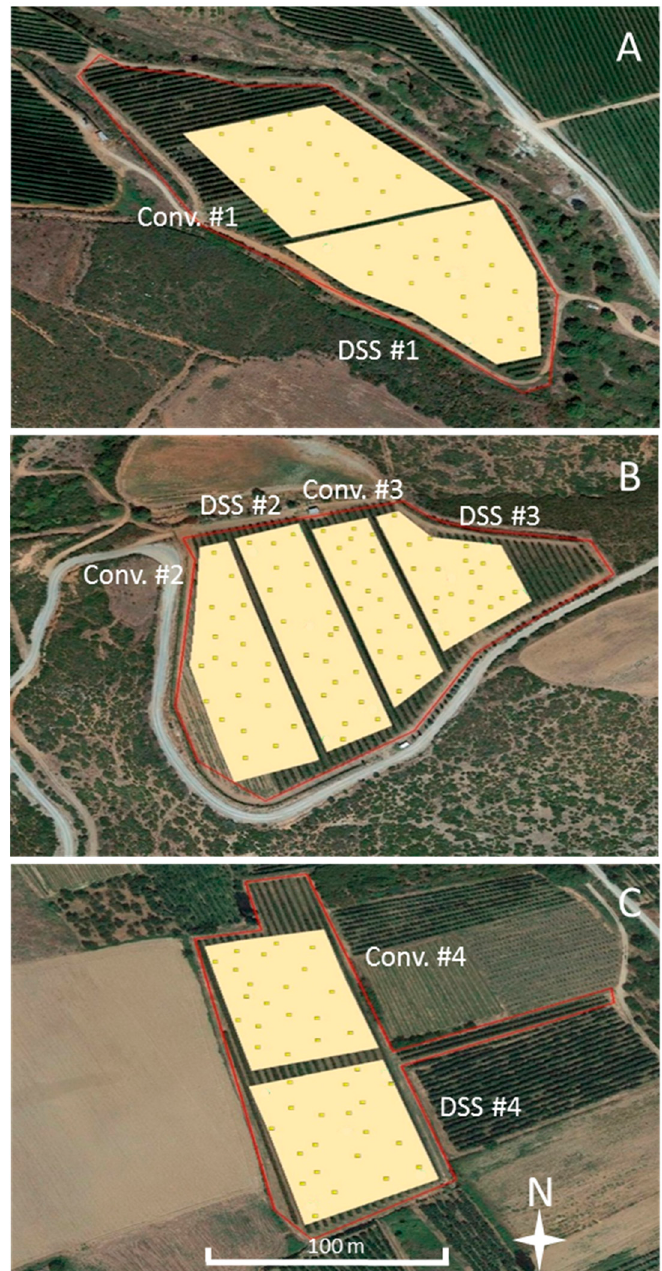
Figure 5. Digitization of coventionally treated (Conv.) and DSS treated plots in commercial cherry orchards. Yellow points indicate the position of Rebell traps. ( A ) Orchard #1, ( B ) Orchard #2, and ( C ) Orchard #3.